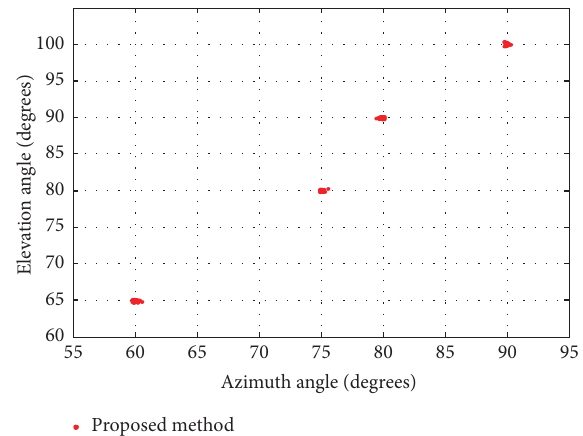
Figure 4: Scatter plot for azimuth and elevation for four uncorre- latedsourcesat (65 ∘ , 60 ∘ ) , (80 ∘ , 75 ∘ ) , (90 ∘ , 80 ∘ ) ,and( 100 ∘ ,90 ∘ ) atSNR = 10 dB using proposed method.